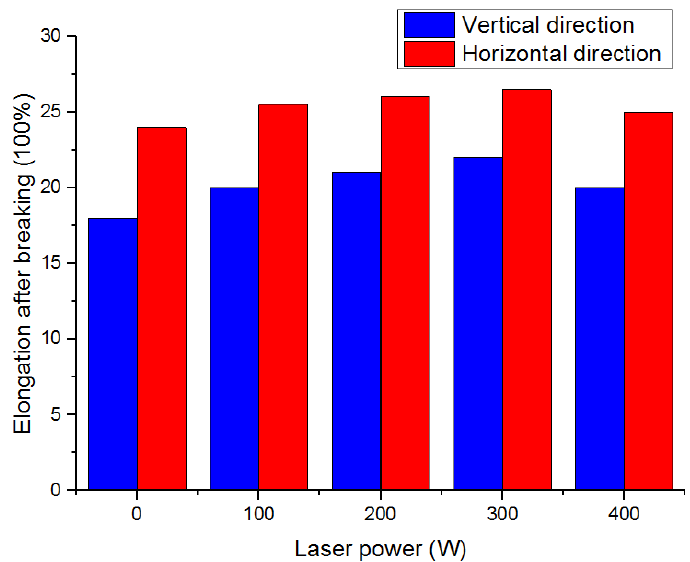
Figure 13. Effect of different laser powers on elongation after breaking.